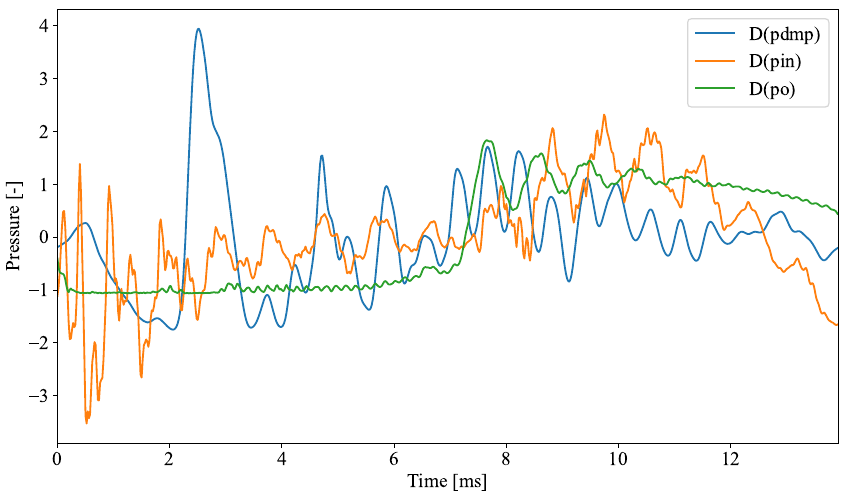
Figure 2. Pressure signals from an individual sample. The pressure signal of the hydraulic rock drill was collected when fault D occurred with the pdmp, pin, and po sensors. The pressure data were normalized and, hence, we did not add the